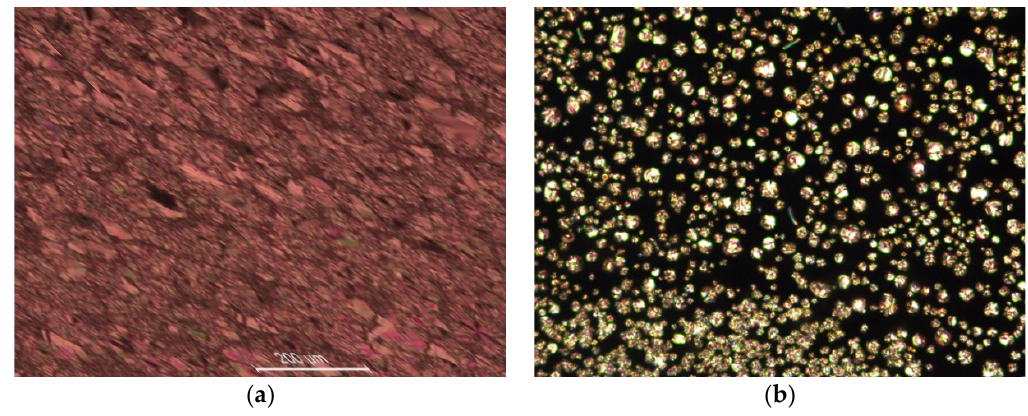
Figure 6. Mesophase textures observed for 10-BPhCOOH under polarized light upon cooling from isotropic liquid. ( a ) Smectic C mesophase between 170 °C and 249 °C; ( b ) Nematic mesophase at T = 249 °C.